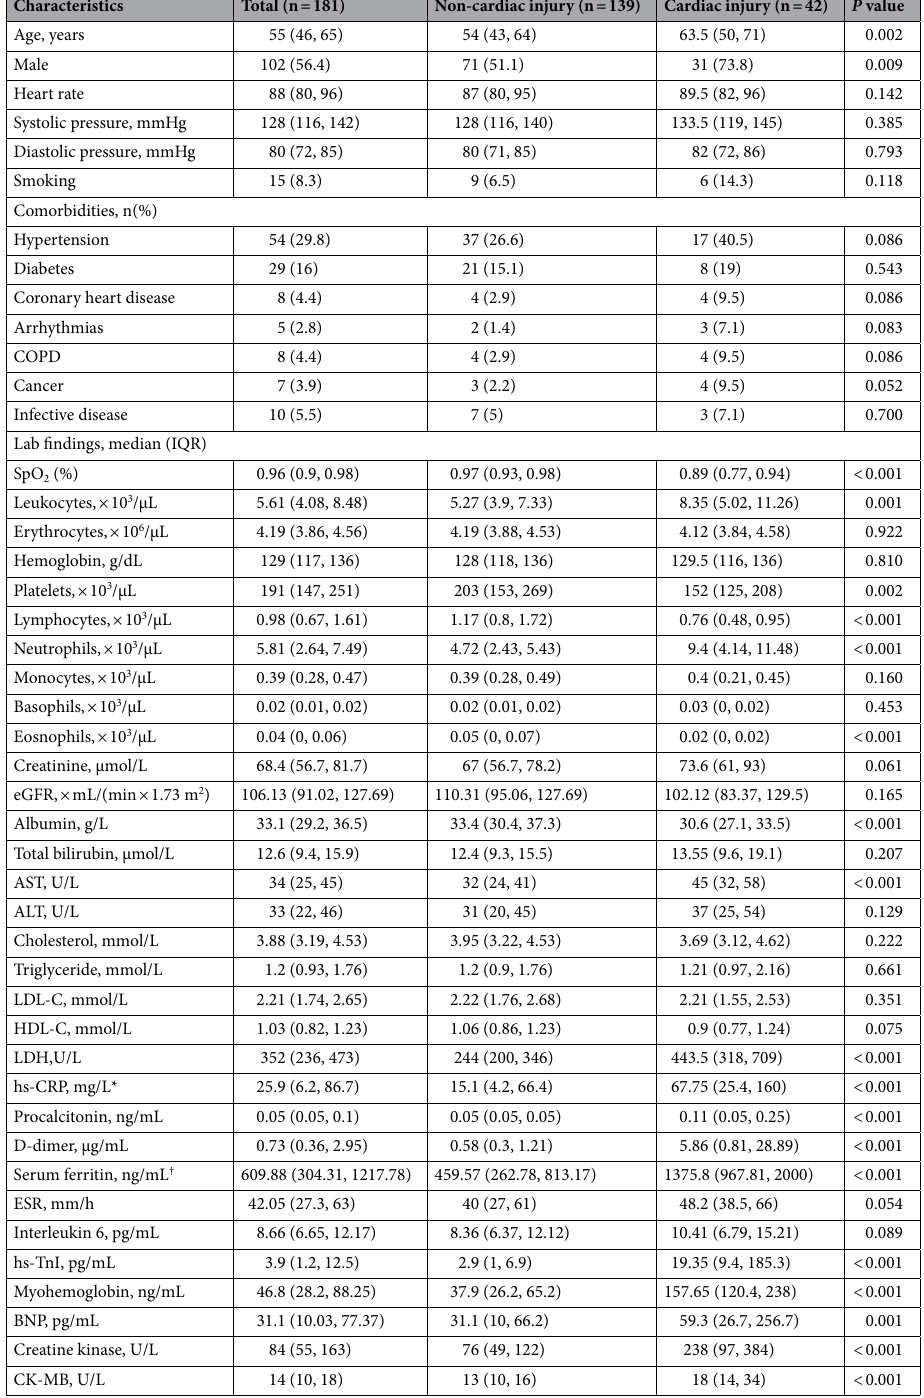
Table 1. Clinical characteristics of patients with or without cardiac injury. ALT: alanine aminotransferase; AST: aspartate transaminase; BNP: B-type natriuretic peptide; CK-MB: creatine kinase-myocardial band; COPD: chronic obstructive pulmonary disease; eGFR: estimated glomerular filtration rate; ESR: erythrocyte sedimentation rate; HDL-C: high density lipoprotein cholesterol; hs-CRP: high-sensitivity C-reactive protein; LDH: Lactic dehydrogenase; LDL-C: low density lipoprotein cholesterol. *Extra levels of hs-CRP were shown as > 160; † extra levels of serum ferritin shown as >